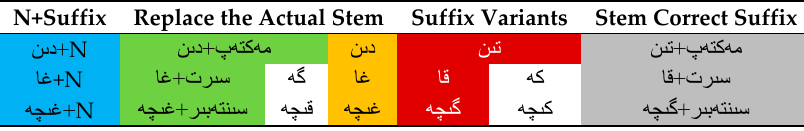
Table 6. Part of example of the noun stem variants.